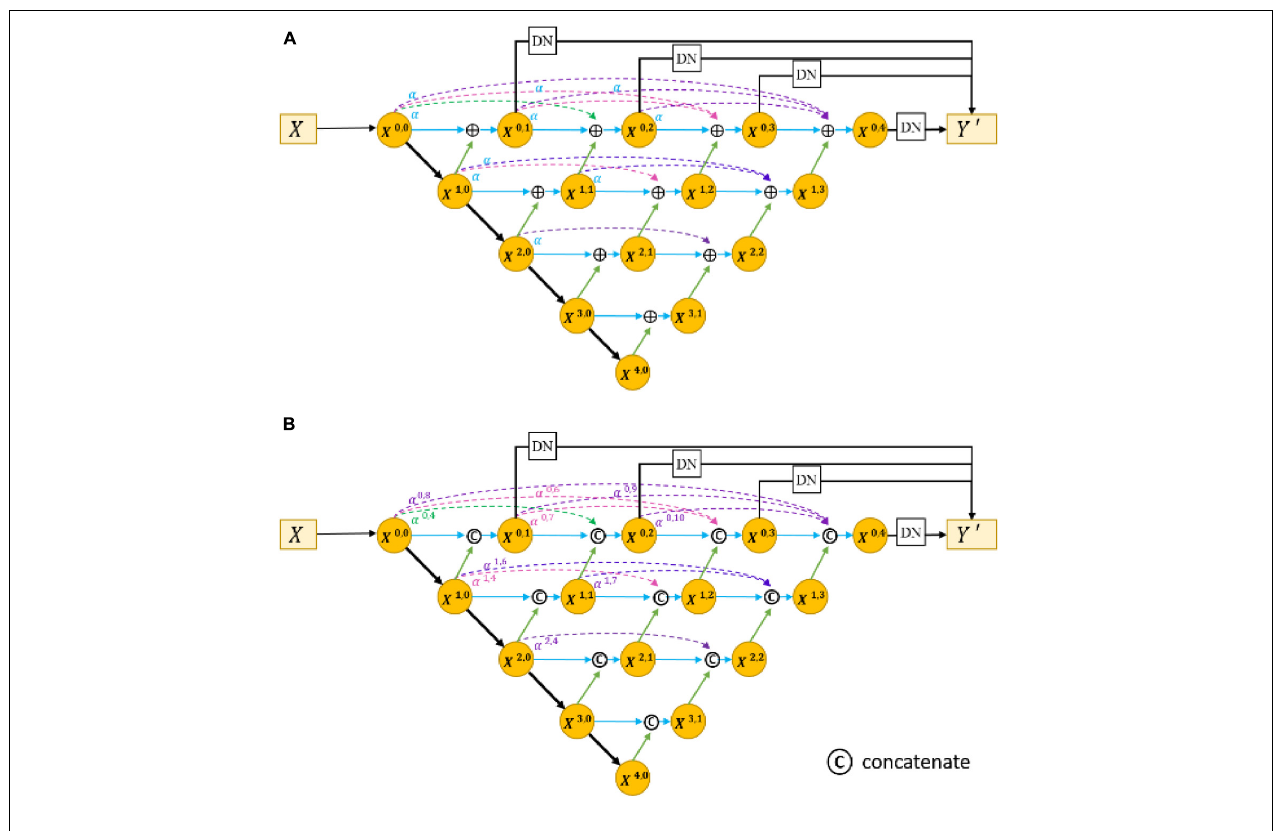
FIGURE 7 | Architecture of Res18UNet++ (A) and AdaptiveUNet++ (B)